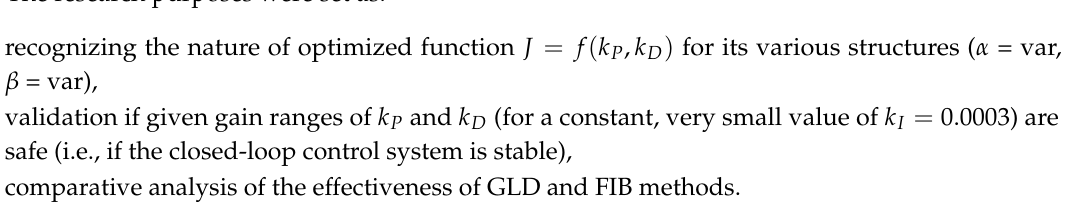
Table 4. Gains of Bebop’s controllers used in experiments. X